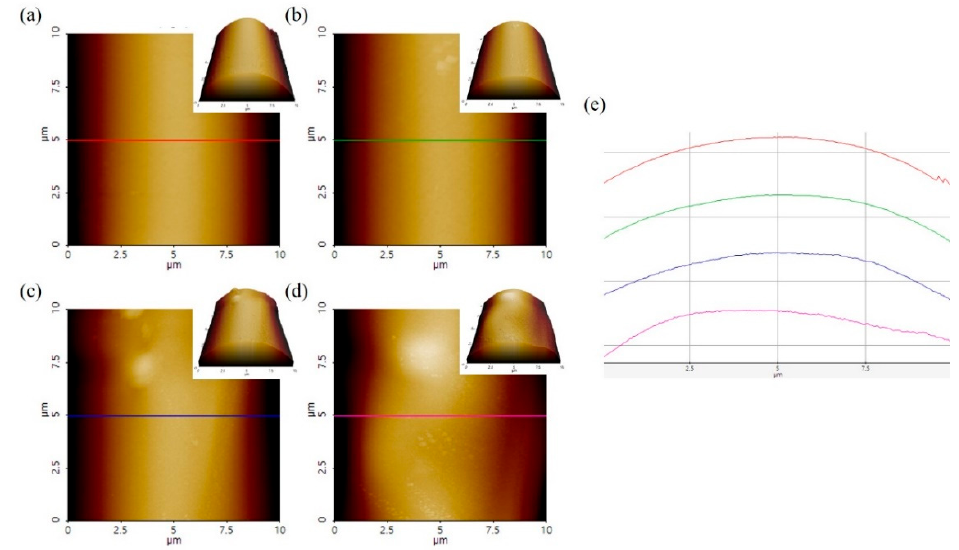
Figure 6. AFM surface morphology of PFO#-based carbon fibers; ( a , b ) PFO # , ( c , d ) PFO # /0.1graphene, and ( e ) height pattern along the color lines.